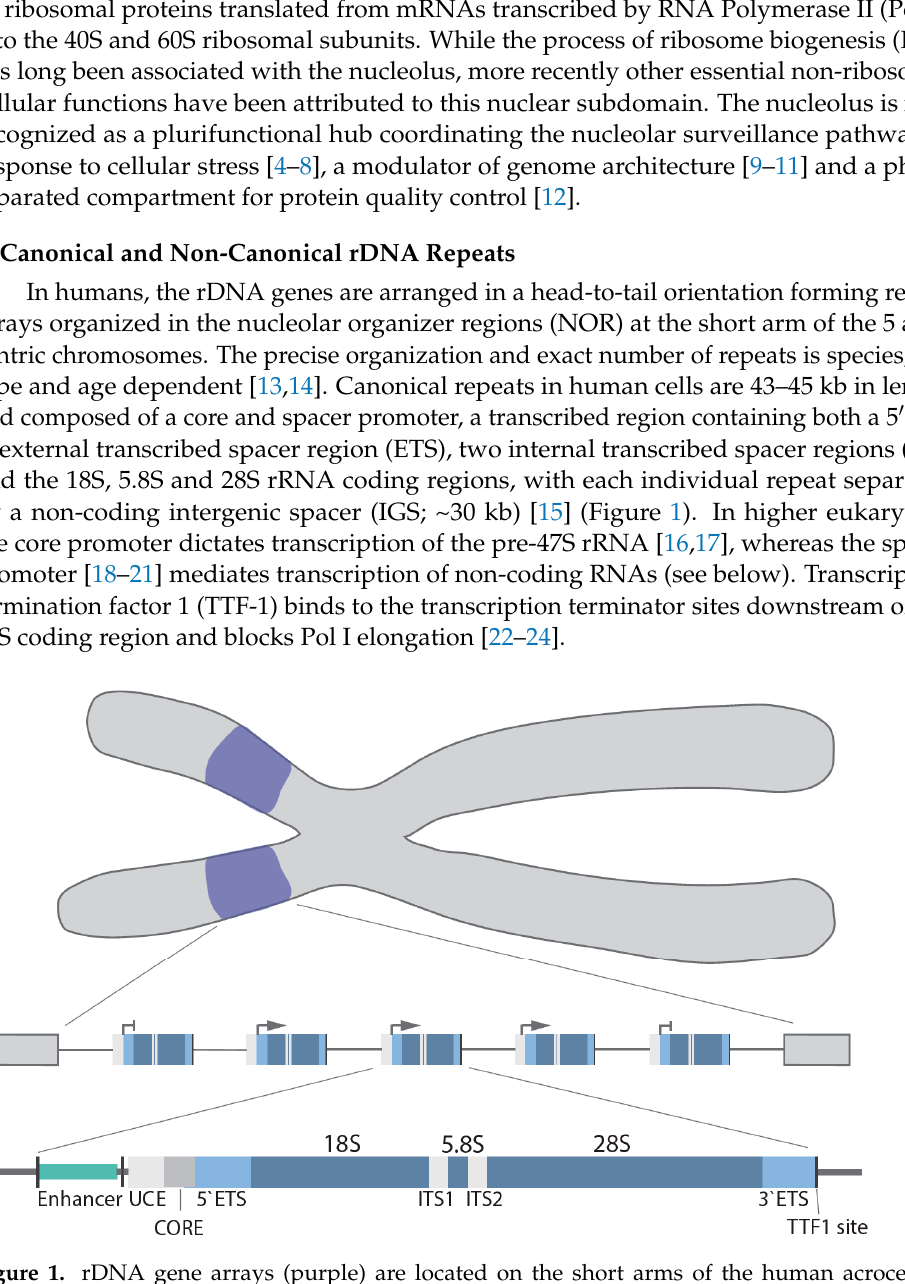
Figure 1. rDNA gene arrays (purple) are located on the short arms of the human acrocentric chromosomes. Organization of a single rDNA gene: enhancer, upstream control element (UCE), core promoter (CORE), 5 ′ /3 ′ external transcribed spacer (ETS), 18S, 5.8S, 28S, internal transcribed spacer (ITS1/2), and transcription terminator factor 1 (TTF-1) site.